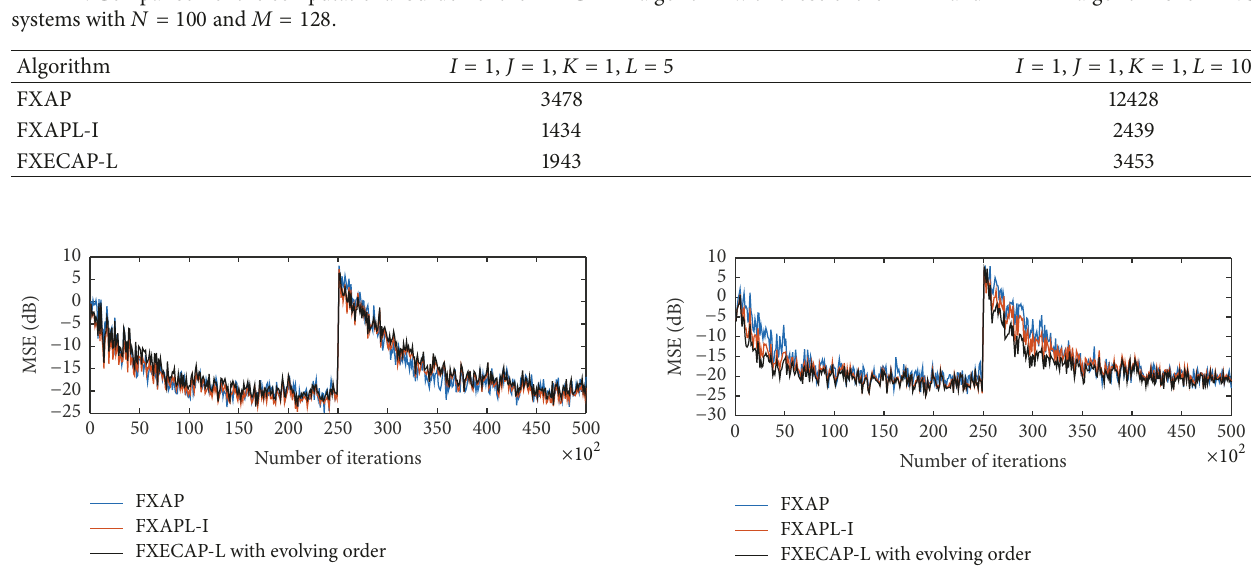
Figure 10: MSE values of the tested AP algorithms in a variant single-channel system. The projection order used is 𝐿 = 5 and 𝑏 = 8 bits are used to encode the error.